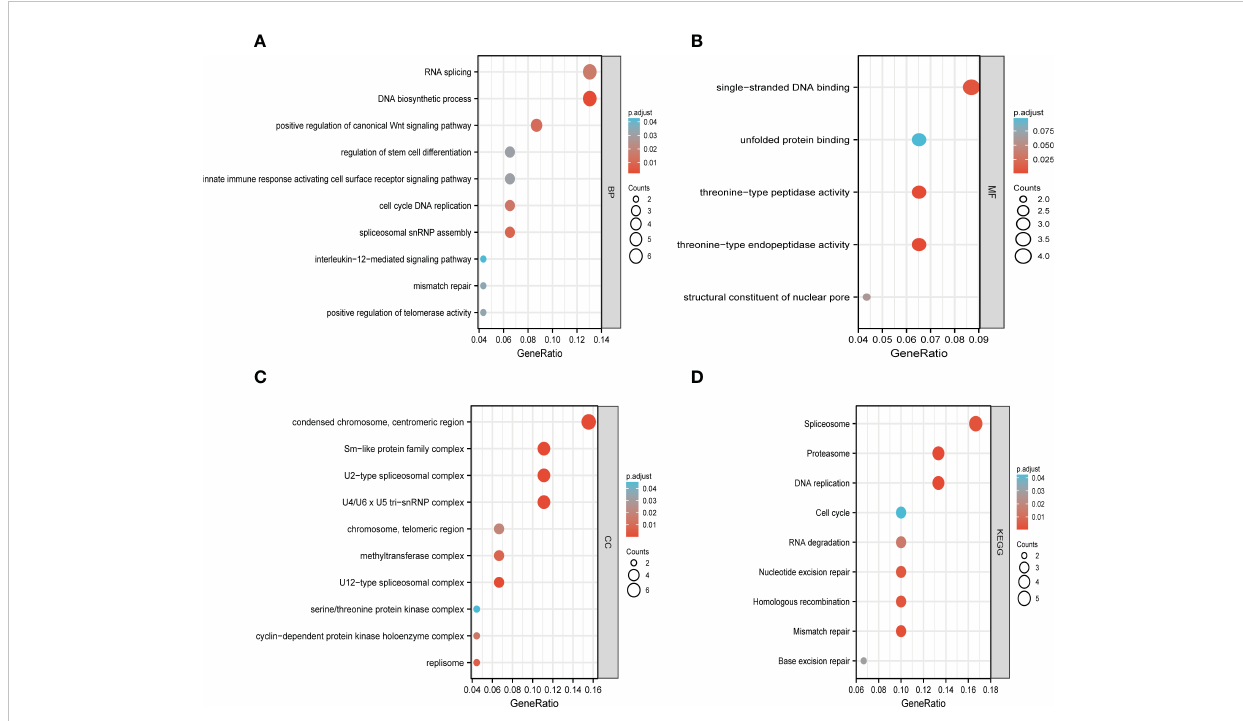
FIGURE 9 Functional enrichment analysis of DEGs based on 50 targeted binding proteins of LSM5 and LSM8 in GC. (A-C) GO enrichment analysis of the LSM5 and LSM8-associated DEGs show the enriched biological functions (BP), cellular components (CC), and molecular functions (MF). (D) KEGG analysis of the LSM5 and LSM8-associated DEGs. Above were analyzed by GEPIA 2database (http://gepia2.cancer-pku.cn/#in http://gepia2.cancer-pku.cn/